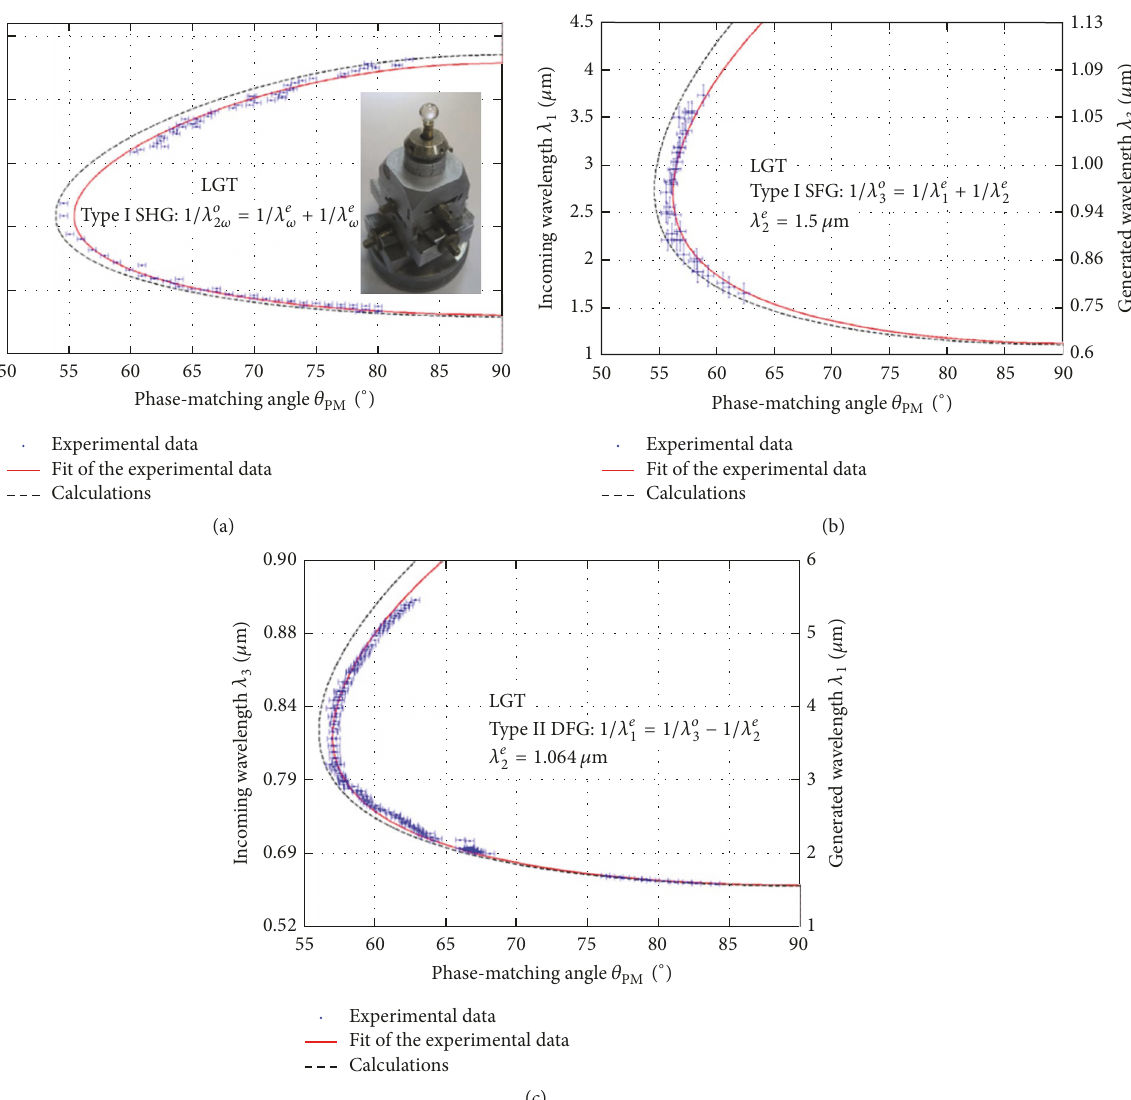
Figure 11: (a) Type I SHG tuning curve of LGT. 𝜆 𝜔 is plotted as a function of the phase-matching angle 𝜃 4.70 mm diameter LGT sphere stuck on a goniometric head. (b) Type I SFG tuning curve of LGT. 𝜆 1 and 𝜆 3 are plotted as a function of the phase-matching angle 𝜃 . (c) Type II DFG tuning curve of LGT. 𝜆 3 and 𝜆 1 are plotted as a function of the phase-matching angle 𝜃 PM Reprinted with permission from [22]. Copyright 2014 Optical Society of